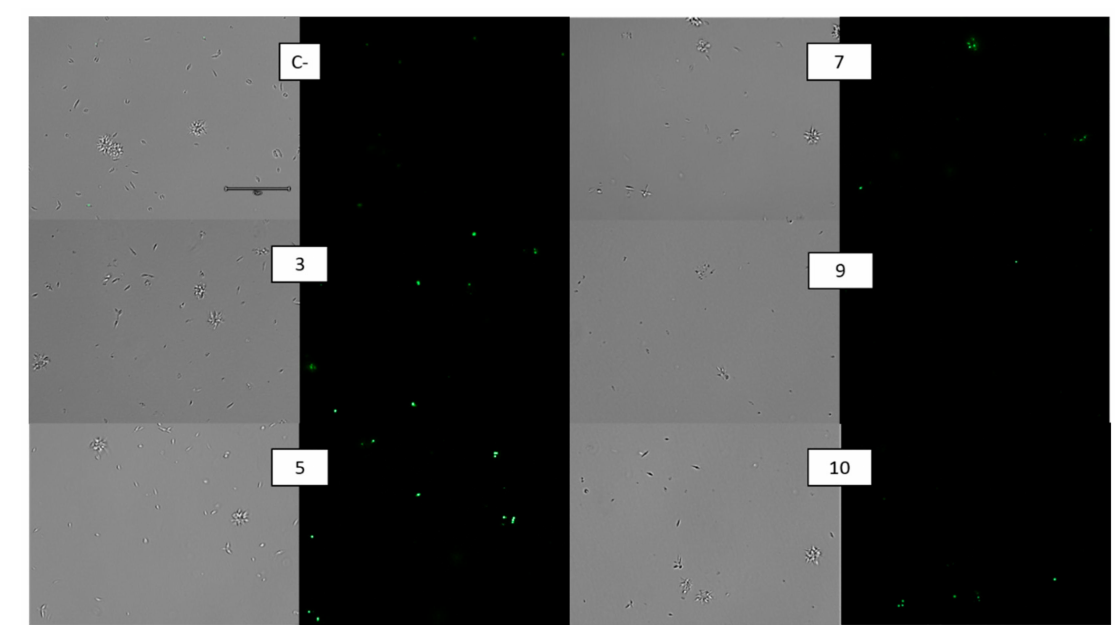
Figure 5. SytoxGreen staining. Results after 24 h of incubation of L. amazonensis promastigotes with the IC 90 of compound. C-: Control. Images were captured using an EVOS FL Cell Imaging system (Thermo Fisher Scientific) (40 × ). Scale: 75 µ